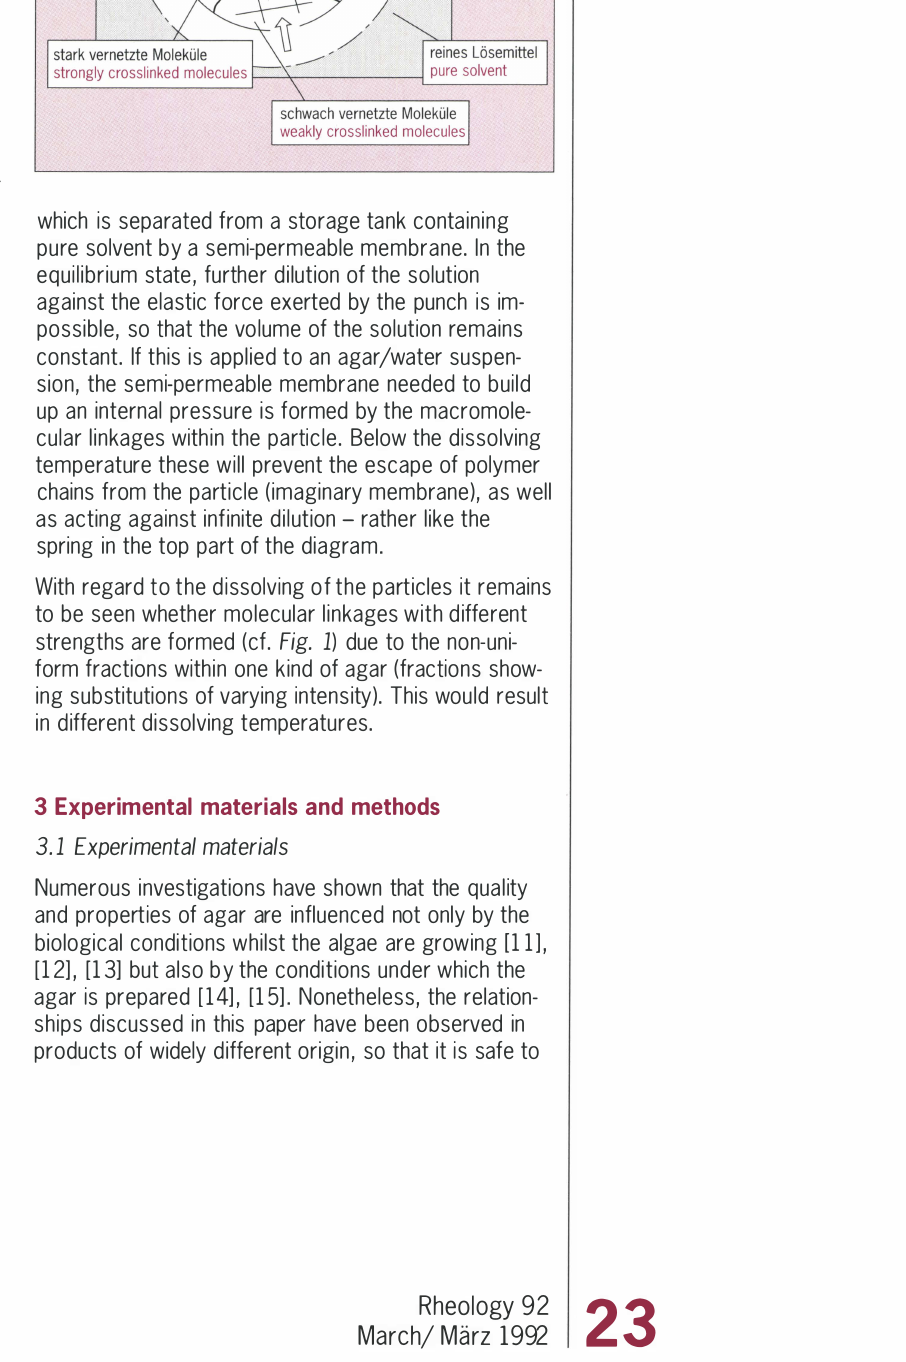
Fig. 1: The agar particle as an osmotic